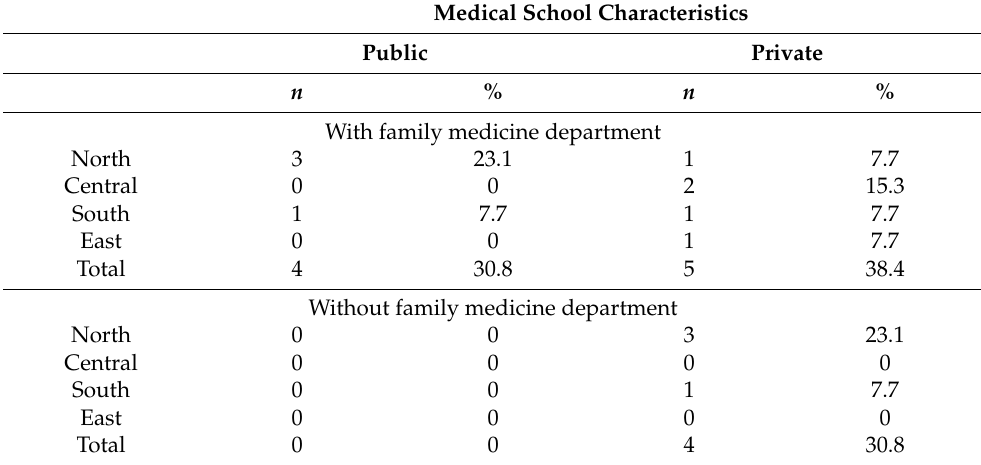
Table 1. Characteristics of medical schools in Taiwan ( n = 13).